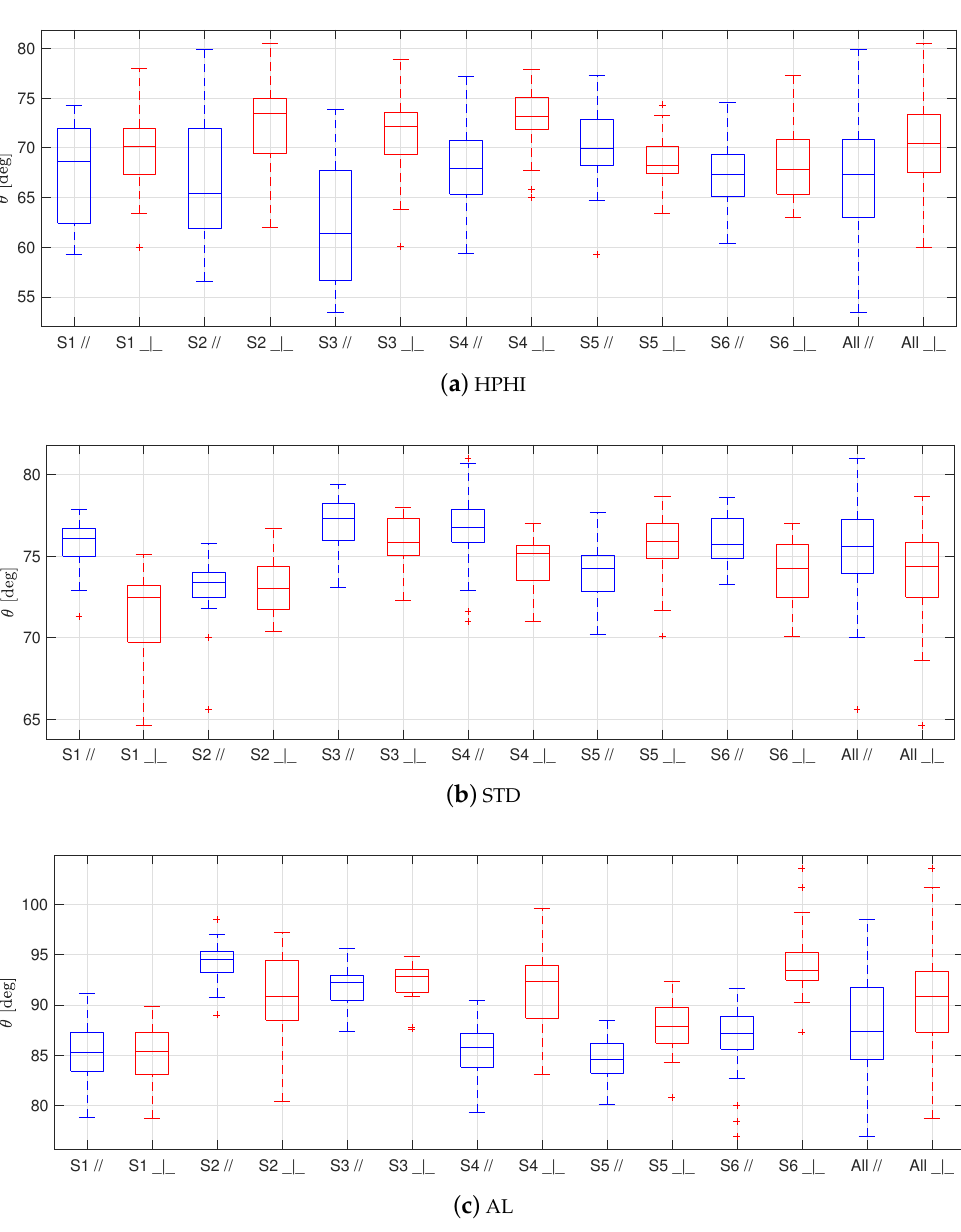
Figure 3. Boxplot representing the static contact angles obtained for the six samples of each of the three surfaces ( S 1, S 2, S 3, S 4, S 5, S 6), and the overall results (All), with the camera lens parallel to the grooves (in blue) and perpendicular to them (in